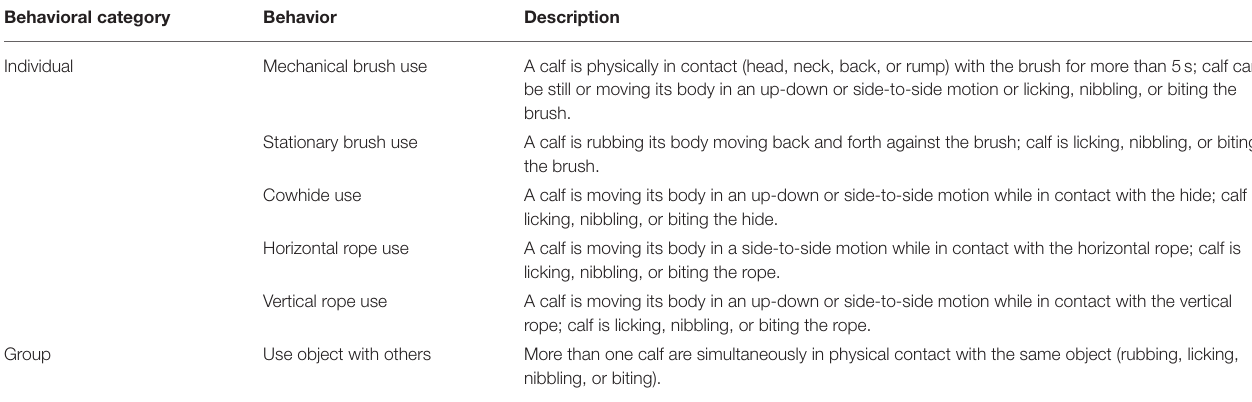
TABLE 1 | Ethogram designed to describe the use and type of object usage with five enrichment objects offered